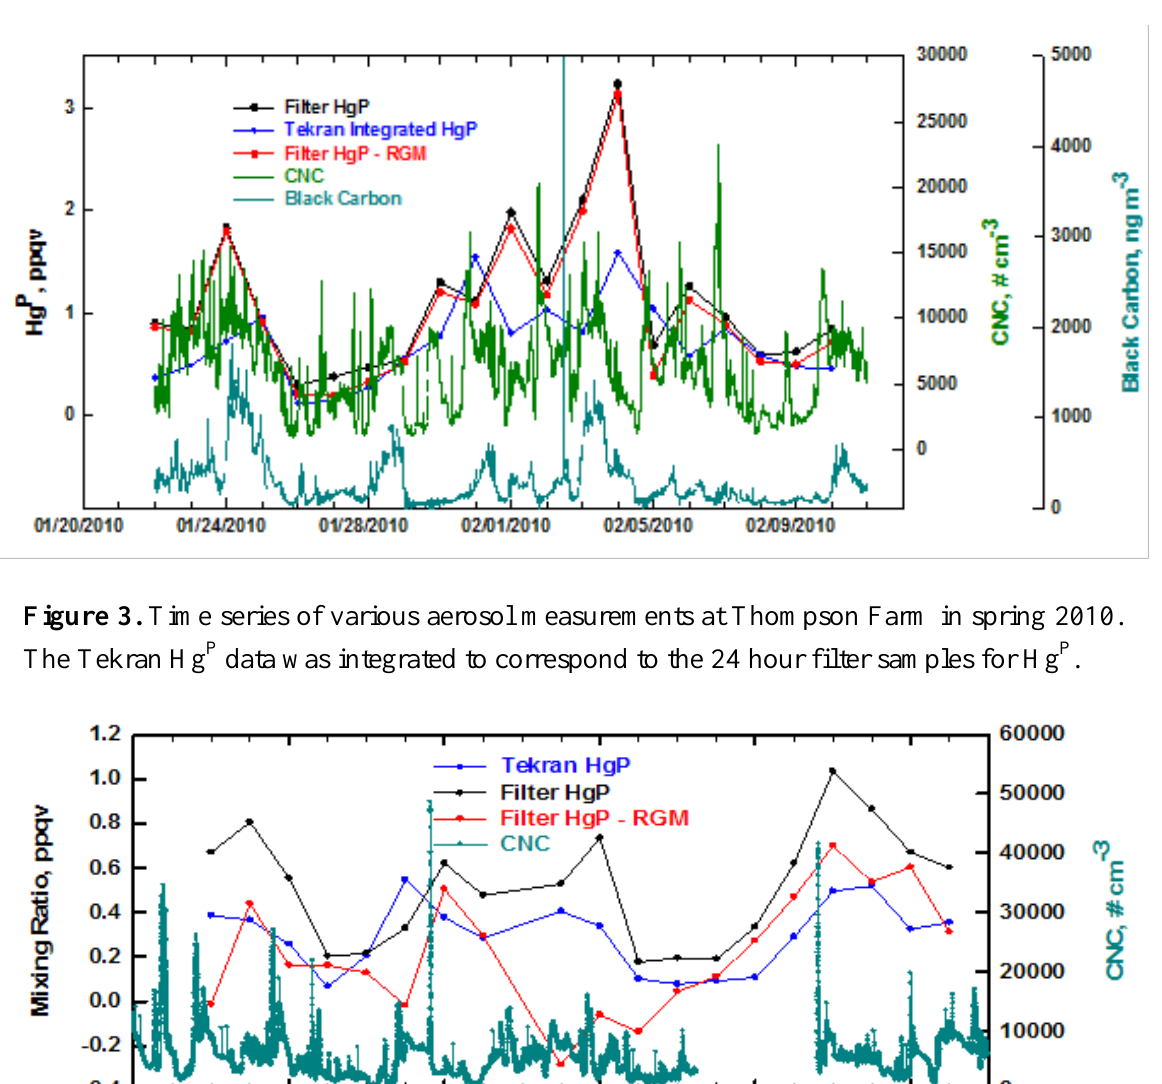
Figure 2. Time series record of various aerosol measurements at Thompson Farm during winter 2010. The Tekran Hg P measurements were integrated to correspond to the 24-hour filter samples for Hg P .